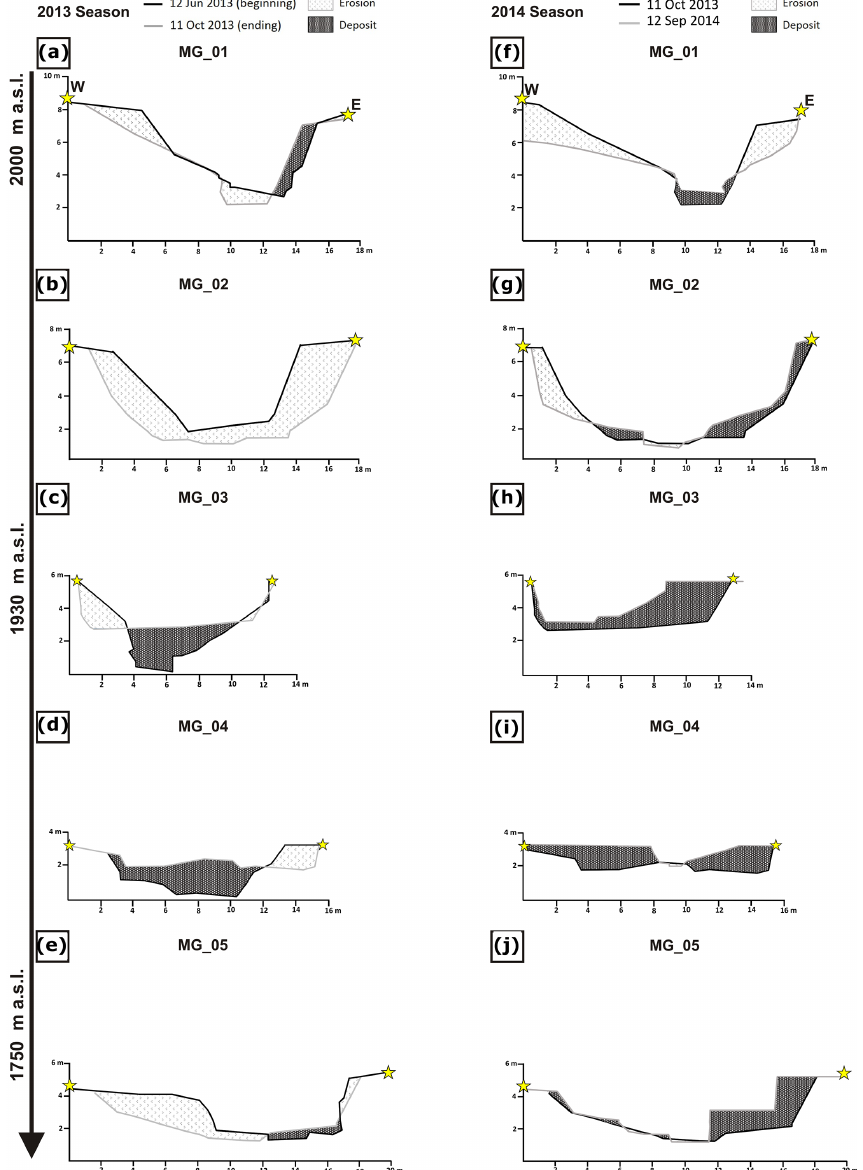
Figure 6. Annual balances during 2013 and 2014 seasons of the E / D processes from the cross-section profiles of the checkpoints at Mon- tegrande ravine (Fig. 1 for location). For the 2013 season: (a) MG_01, (b) MG_02, (c) MG_03, (d) MG_04, and (e) MG_05. For the 2014 season: (f) MG_01, (g) MG_02, (h) MG_03, (i) MG_04, and (j) MG_05. The light fill patterns represent the eroded area within the active channel and the darker fill patterns represent